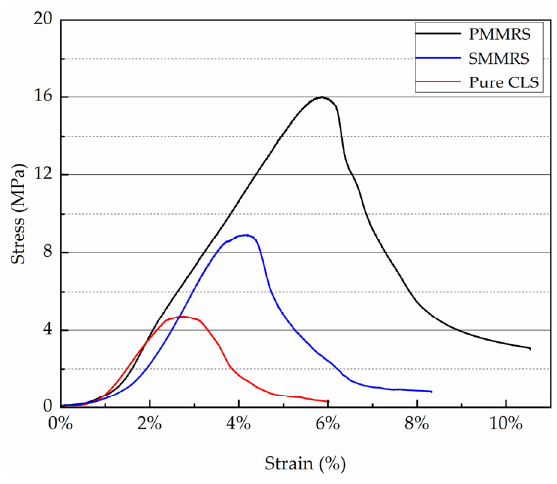
Figure 4. The strain–stress curve of PMMRS, SMMRS and pure CLS. The average UCS for the PMMRS group was the greatest, which was 15.92 MPa, while the corresponding results for the SMMRS and pure CLS specimens were 8.92 MPa and 4.72 MPa, respectively. The average UCS of the PMMRS group was almost three times greater than the pure CLS and was 78% greater than the SMMRS group. Moreover, the displacements under the peak stress for the PMMRS specimens were greater than the pure CLS and SMMRS. Results implied that the pretreatment-mixing MICP method exhibit a higher improvement over the simple mixing MICP